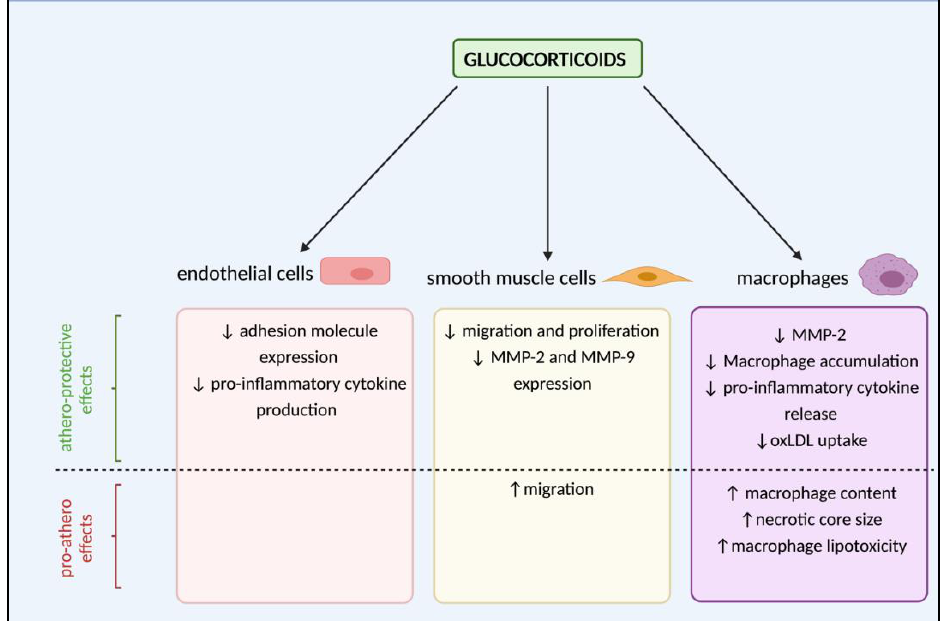
Figure 3. Summary of cell-specific effects of glucocorticoids during atherosclerotic plaque develop- ment. Evidence indicates that glucocorticoids are capable of exerting both athero-protective and pro-atherogenic (pro-athero) effects in several crucial cell types. In endothelial cells, glucocorticoid action is athero-protective. However, in both smooth muscle cells and macrophages, evidence exists of both pro-athero and athero-protective effects. oxLDL—oxidised LDL; MMP—matrix metalloproteinases. However, evidence indicates that glucocorticoid-mediated responses in both vSMCs and macrophages may depend on the experimental model, as well as the level of glucocor- ticoid exposure. Glucocorticoids can have potentially atheroprotective effects on vSMCs